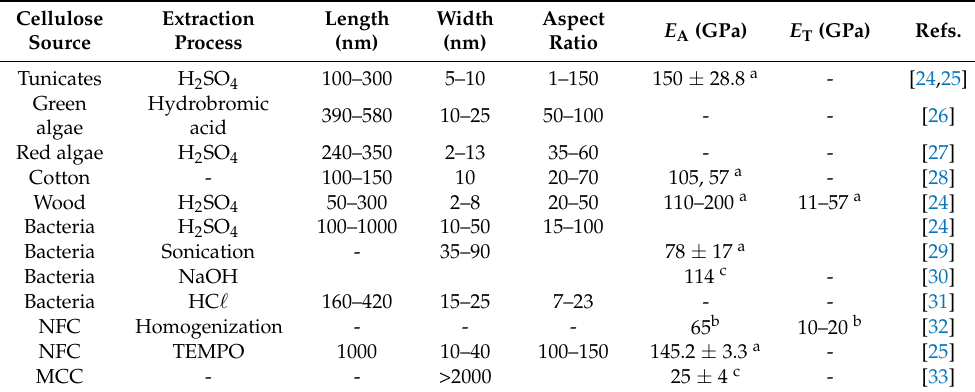
Table 2. Cellulose nanomaterials (CNMs)